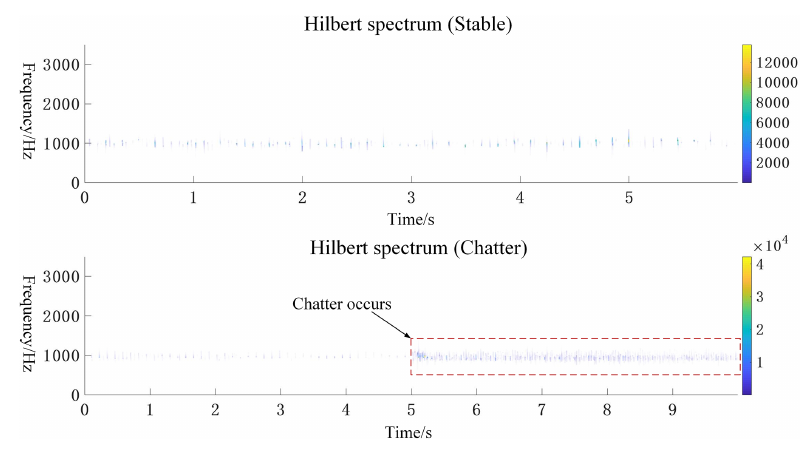
Figure 17. The a 6 frequency band.